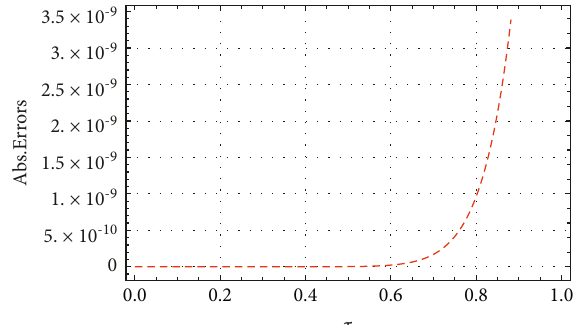
Figure 12: The absolute error for the imaginary part of Example 2.